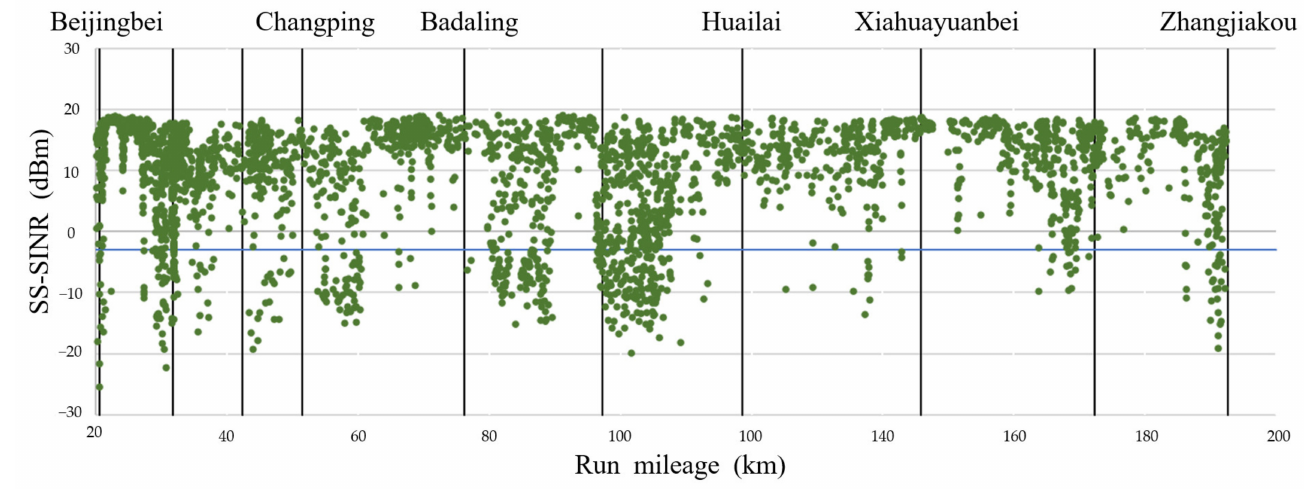
Figure 9. The values of